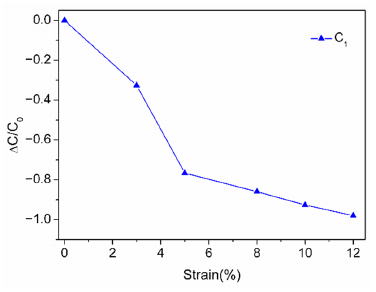
Appl. Sci. 2020 , 10 , x FOR PEER REVIEW Figure 8. The change of capacitance C 1 under strain. Figure 8. The change of capacitance C 1 under strain.